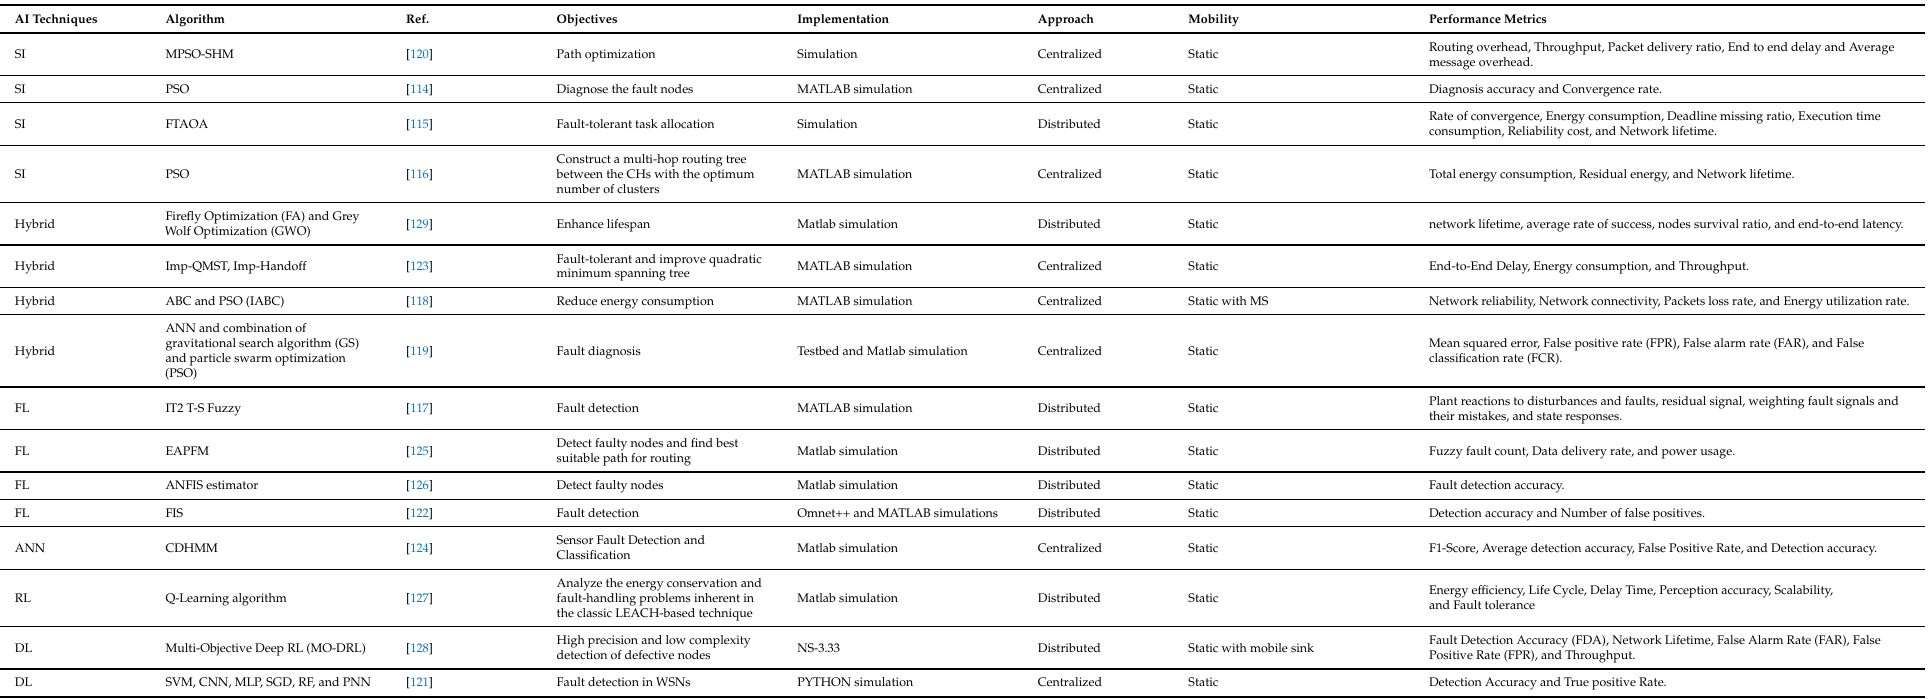
Table 5. Summary of AI-based solutions to fault detection and tolerance surveyed in Section